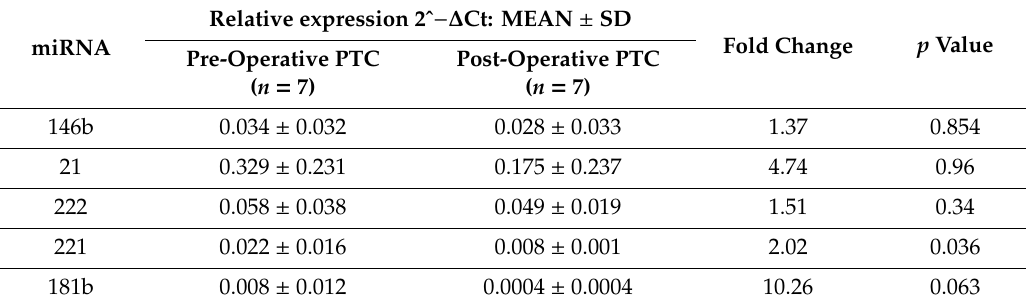
Fold Change p Value